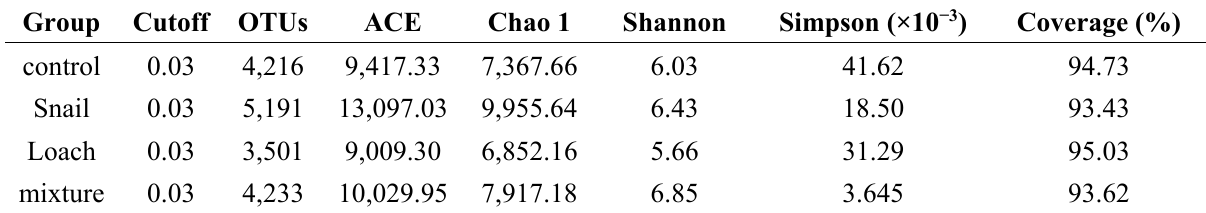
Table 3. Comparison of phylotype coverage, diversity, and richness estimators at a phylogenetic distance of